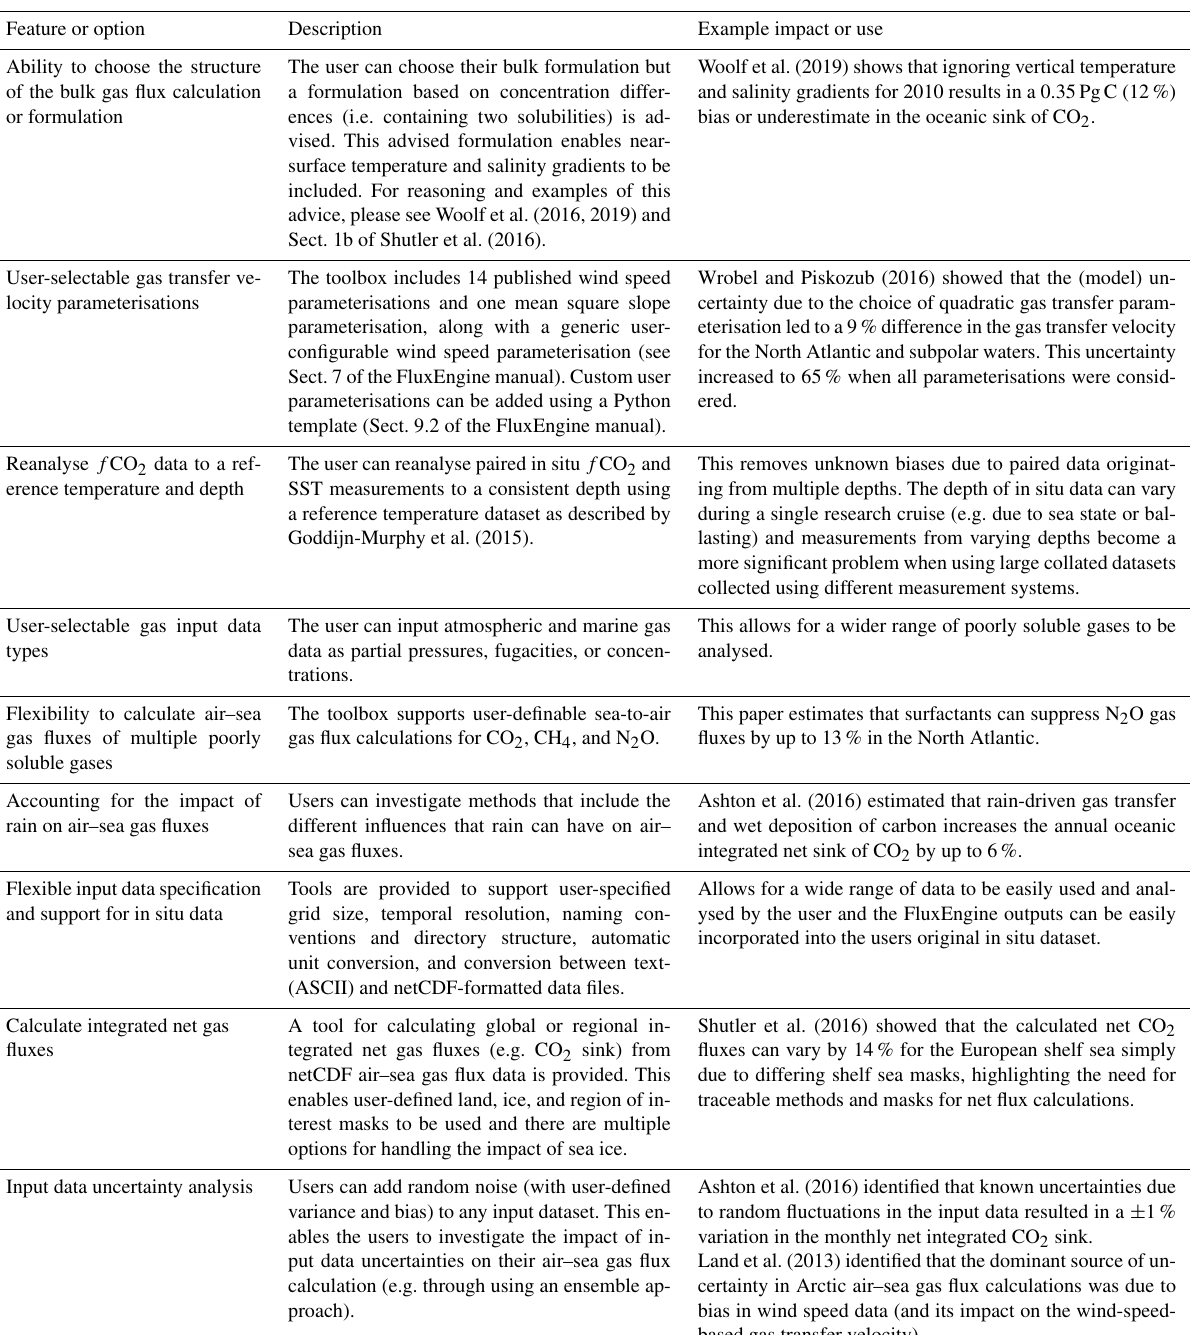
Table C1. An overview of the key features provided by the FluxEngine software toolkit and their relevance or use for atmosphere–ocean gas